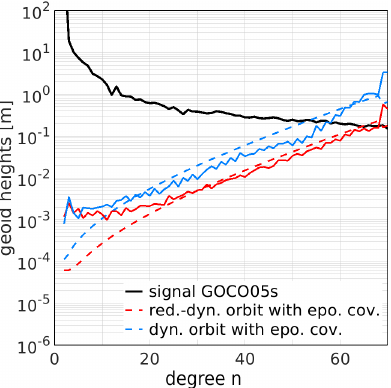
Figure 3. Monthly GRACE GPS-only gravity field solution (April 2007) based on a reduced-dynamic orbit (red) and a dynamic orbit (blue). The solid lines depict the difference degree amplitudes to GOCO05s, the dashed lines denote the formal errors from the least-squares adjustment.